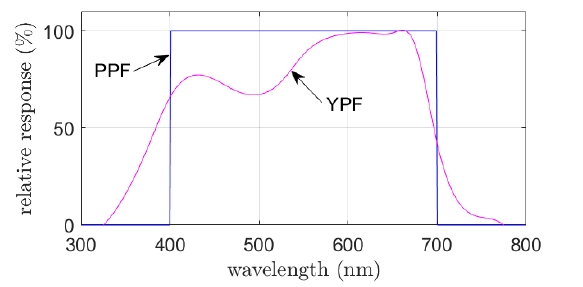
Fig. 4. Measured spectral irradiance densities on a sunny day with and without a plastic